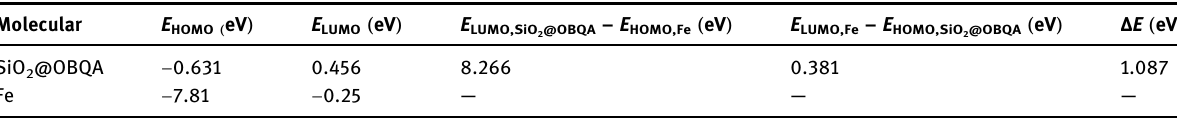
Table 1: Frontier orbital energies of nano - SiO 2 @OBQA